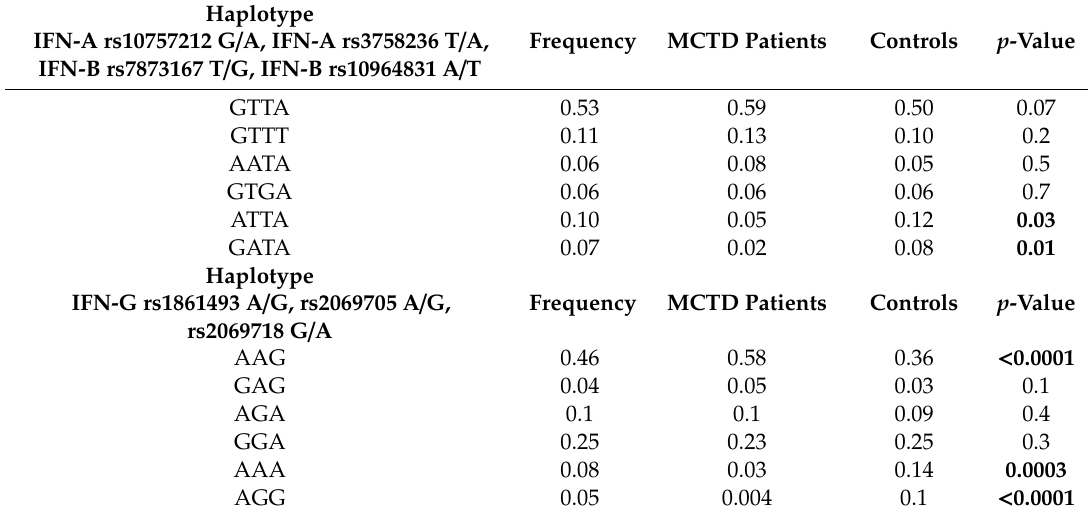
Table 4. Haplotype analysis results among two single nucleotide polymorphisms (SNPs) in IFN-A locus, two SNPs in IFN-B locus and three SNPs in INF-G